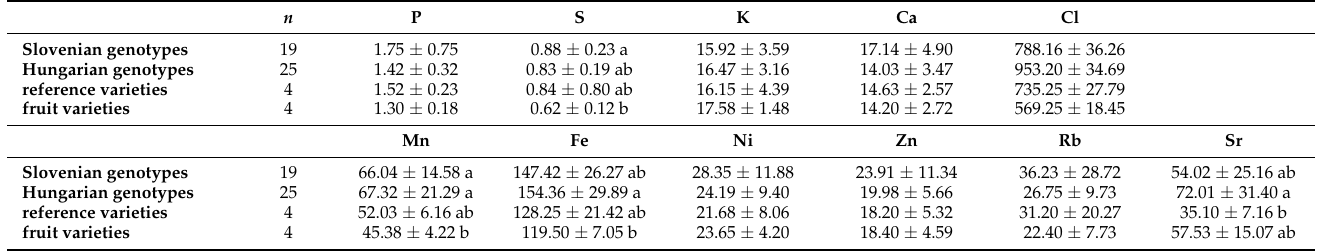
Table 2. Mean concentrations ( ± SD) of the macroelements (g/kg DW) and the predominant mi- croelements (mg/kg DW) in mulberry leaves in Slovenian, Hungarian mulberry varieties, reference sericultural varieties, and fruit varieties. Different letters (a, b) indicate significant differences ( p < 0.05), which were determined using the post hoc Duncan test. n , number of repetitions. n P S K Ca